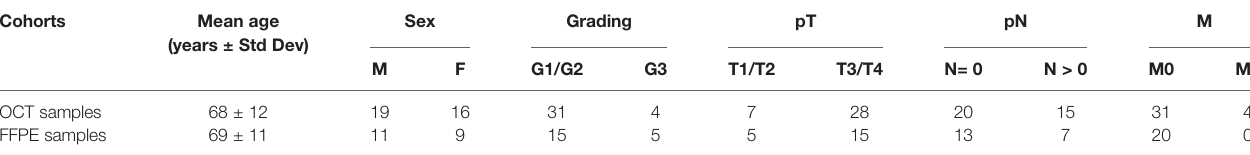
TABLE 1 | Colorectal cancer (CRC) biopsies analyzed in this study. Cohorts Mean age (years ± Std